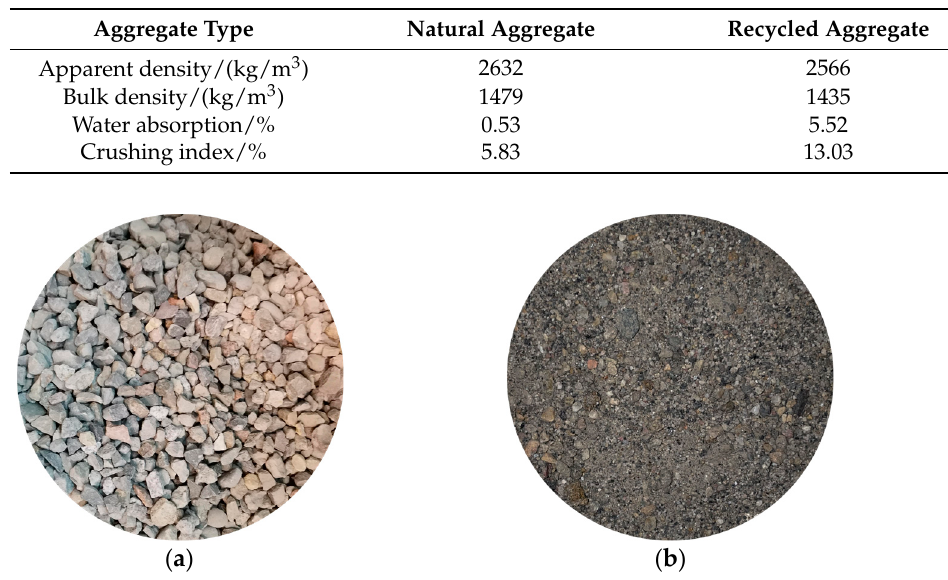
Figure 4. The photo of the aggregate: ( a ) The recycled coarse aggregate; ( b ) The fine aggregate. Table 1. Performance parameters of coarse aggregate.